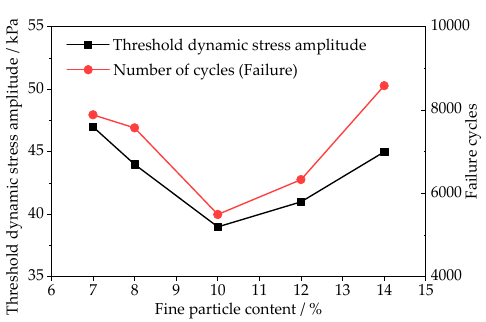
Figure 5. Threshold dynamic stress amplitude and failure cycles of the silt with different fine particle contents.